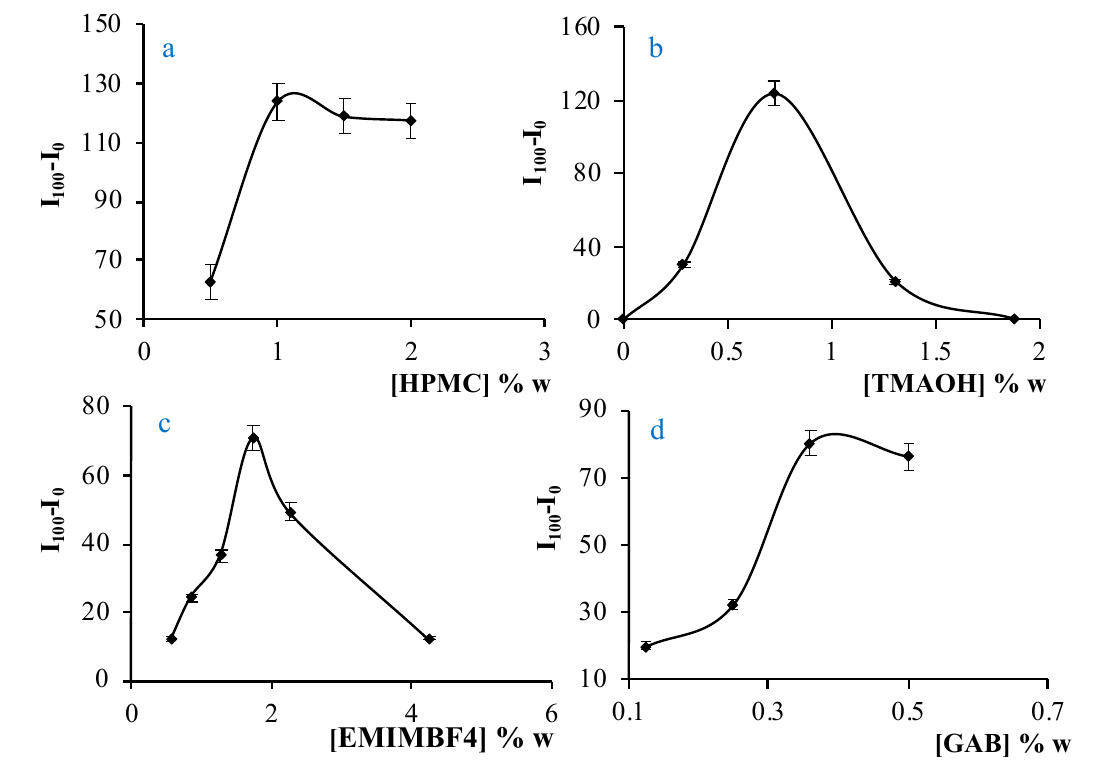
Figure 1. Optimization of reagent concentration for sensing membrane containing IL: ( a ) HPMC; ( b ) TMAOH; ( c ) EMIMBF 4 ; ( d ) GAB.